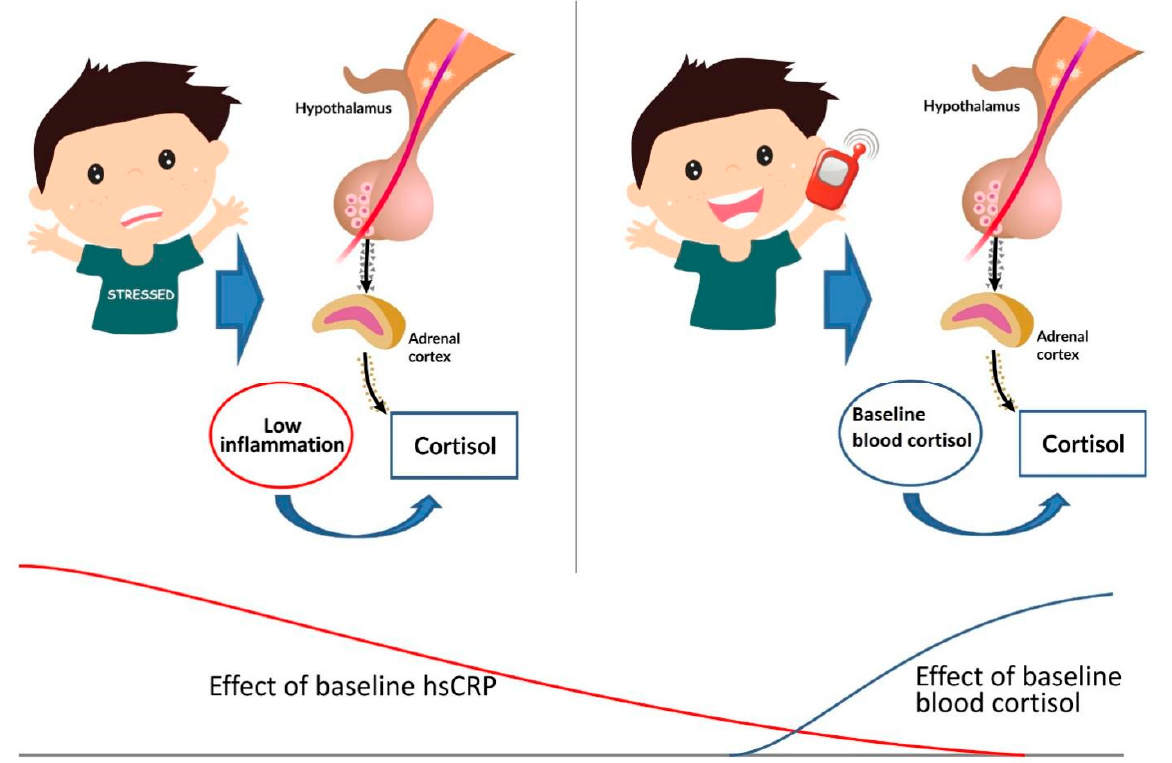
Figure 4. The effect of baseline circulating hsCRP and cortisol on salivary cortisol dynamics during consecutive stimuli.